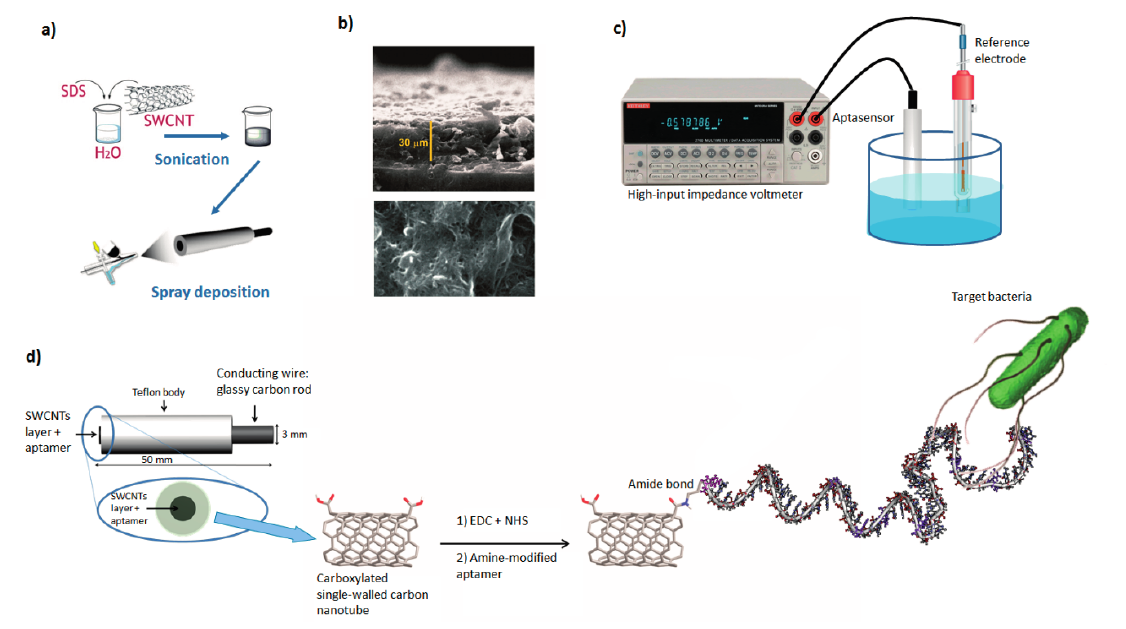
Figure 7. Schematic of the potentiometric-based detection of pathogenic bacteria using Apt-SWCNTs. ( A ) Deposition of SWCNTs on a glassy carbon electrode surface; ( B ) Environmental scanning electron microscope image of the deposited layer of